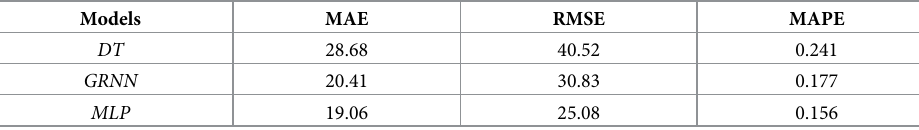
Table 3. The comparisons of three developed models.